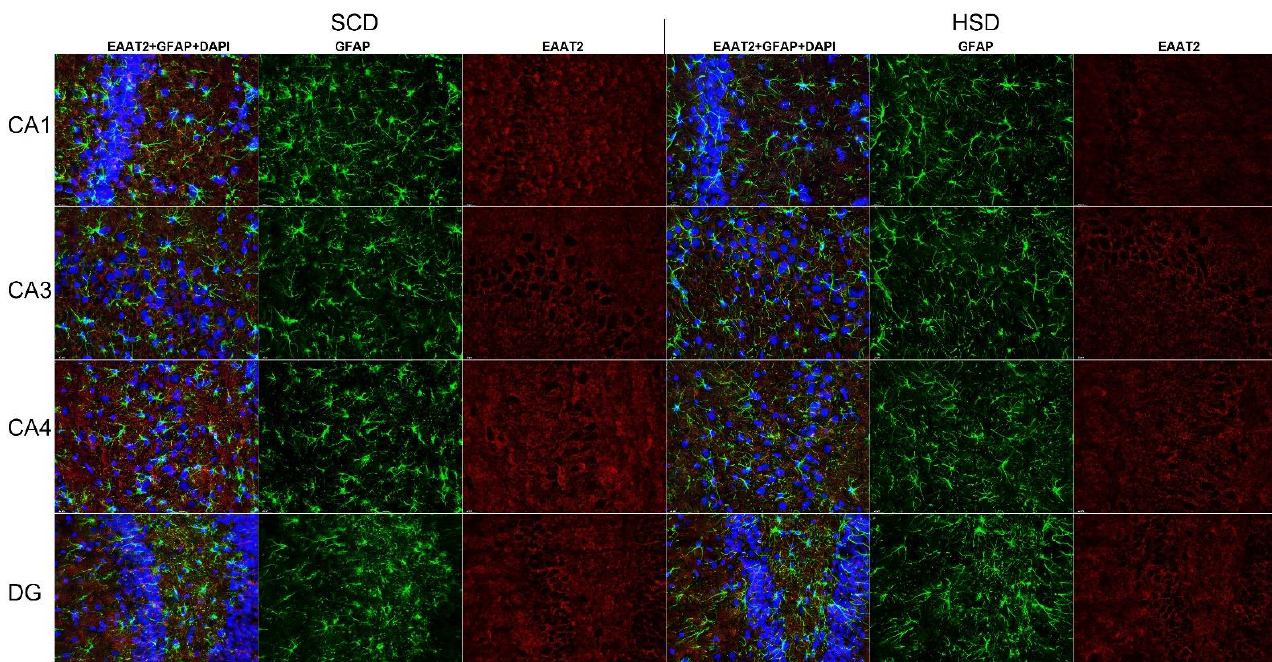
Figure 9. Immunohistofluorescence staining of EAAT2 localization on astrocytes in the HIP of female offspring. Representative images showing EAAT2 immunoreactivity (red) in GFAP positive astrocytes (green) with DAPI-stained nuclei (blue). n = 6 in each group. Magnification × 40, scale bar 20 μm.